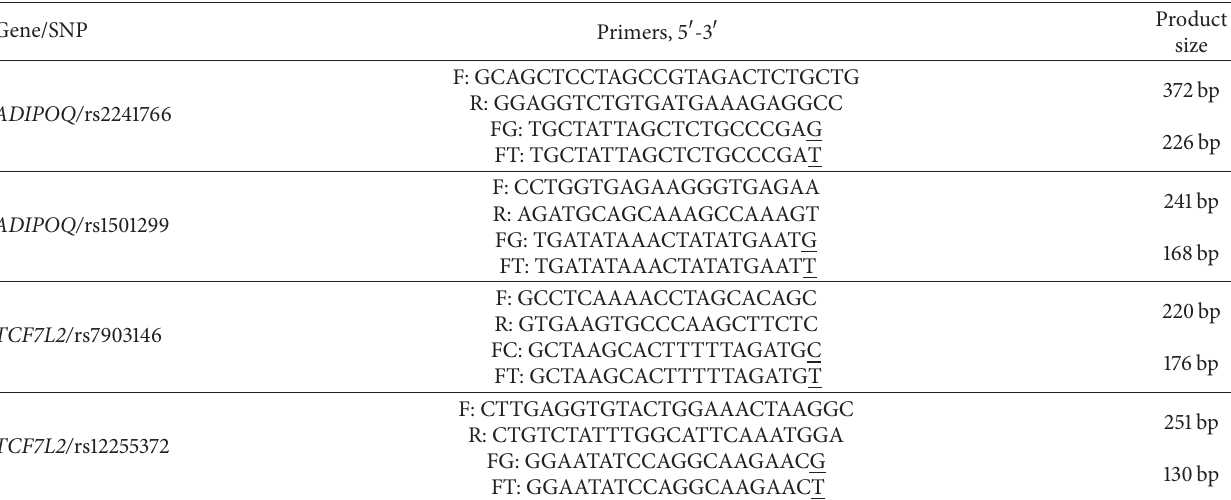
Table 2: Primers utilized in allele-specific PCR analysis.